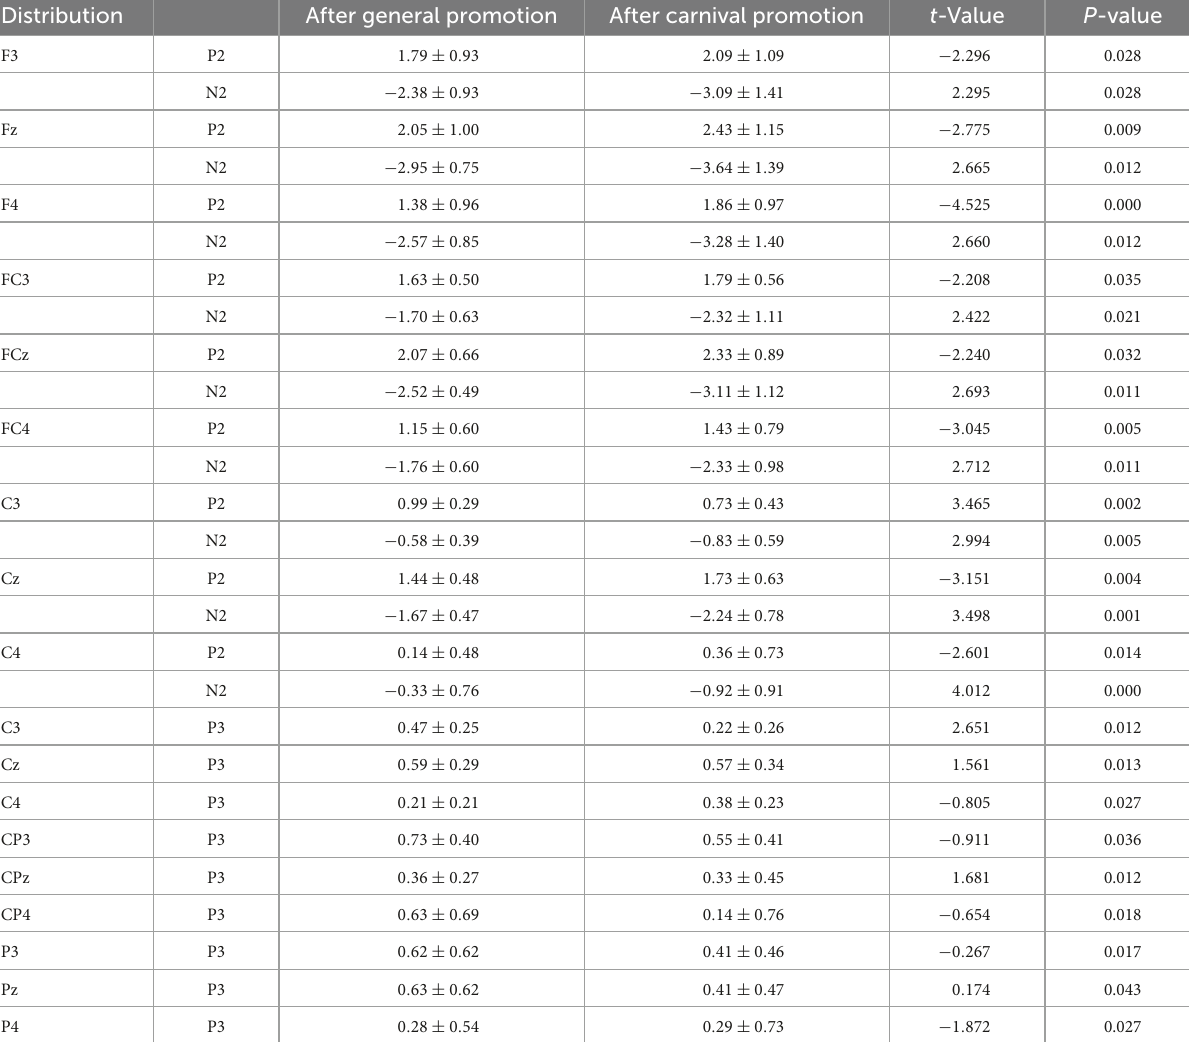
TABLE 1 Basic descriptive statistics of evoked potentials.